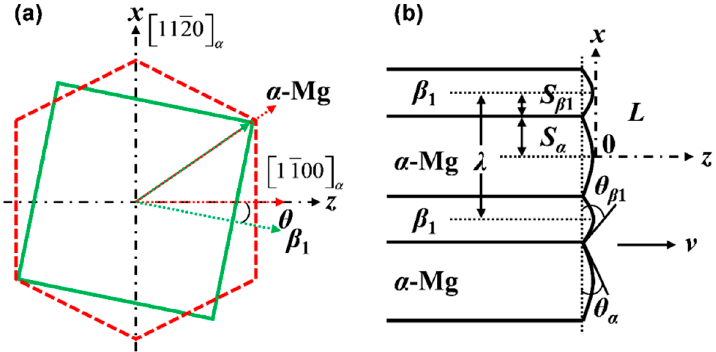
Figure 1. ( a ) Lattice vectors corresponding to the (011) β 1 and (0001) α planes of β 1 and α -Mg [34]; ( b ) schematic diagram of the lamellar eutectic structure at the eutectic dendrite tip region [35].